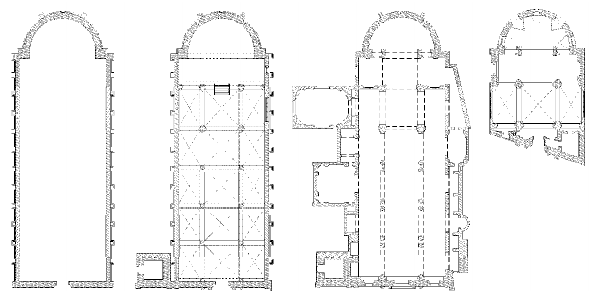
Figure 5. Maps of the church in different historical periods, normalized through the real 3D data: a) VI century; b) XIII century; c) XVI century; d) XIX